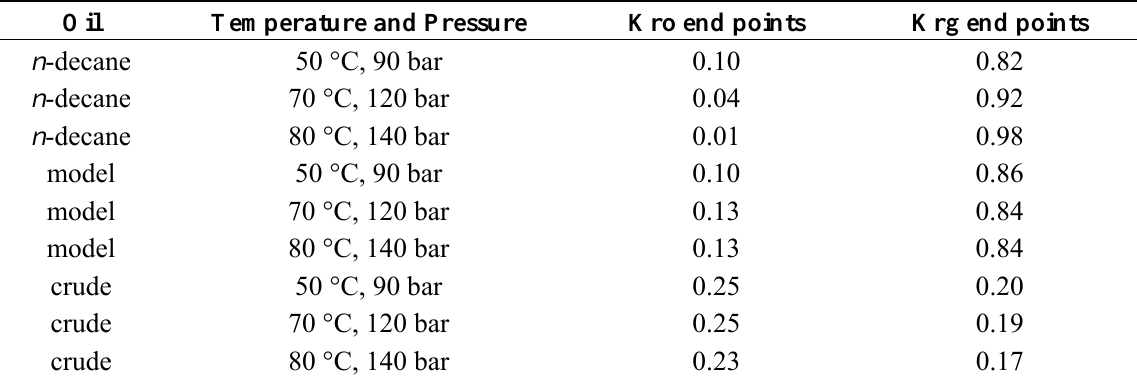
Table 1. Estimated end points relative